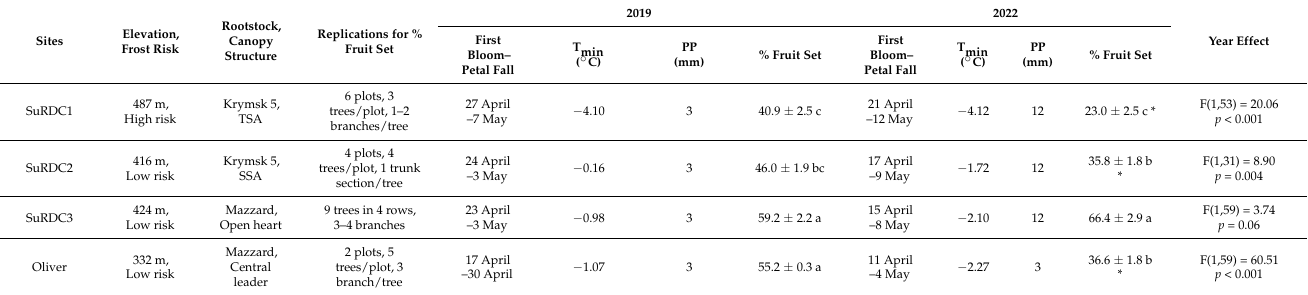
Table 1. Site description, phenology and percent fruit set of ‘Lapins’ sweet cherry at five monitored sites in the Okanagan Valley, British Columbia, Canada, in the spring of 2019 and